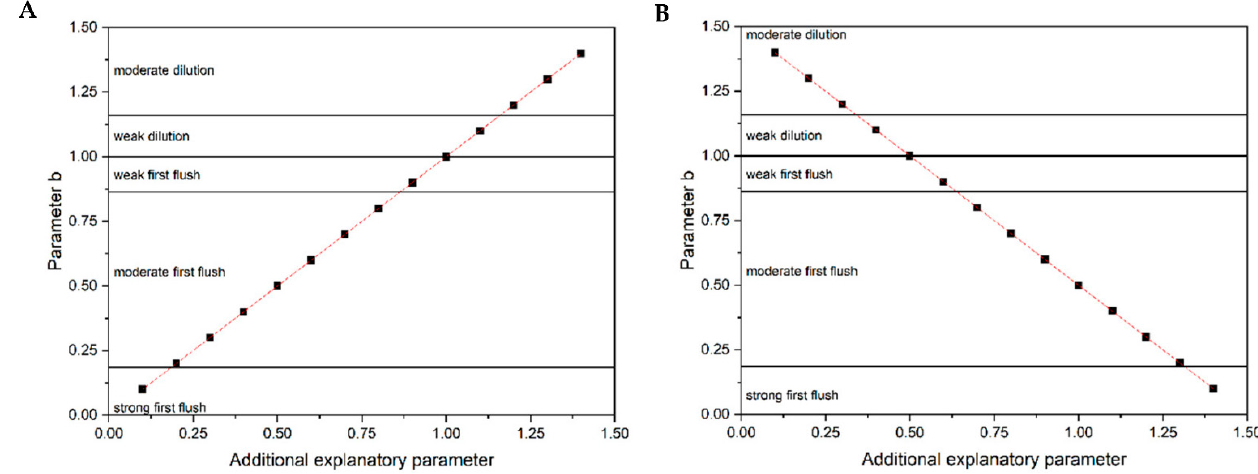
Figure 2. Examples for a positive ( A ) and negative ( B ) correlation including parameter b.